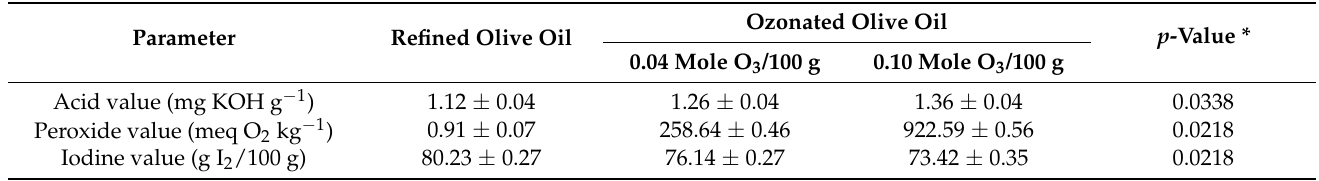
Table 4. Characteristic chemical parameters of refined and ozonated olive oils.